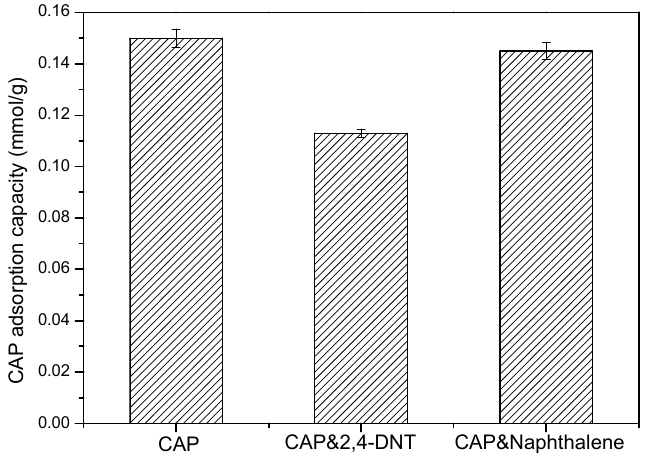
Figure 7. Competition experiments of CAP and 2,4-DNT/naphthalene adsorption on AC. (chloramphenicol concentration = 0.1 mmol/L, 2,4-DNT concentration= 0.05 mmol/L, naphthalene concentration = 0.05 mmol/L dosage = 30 mg/50 mL, time = 24 h, temperature = 25 °C).